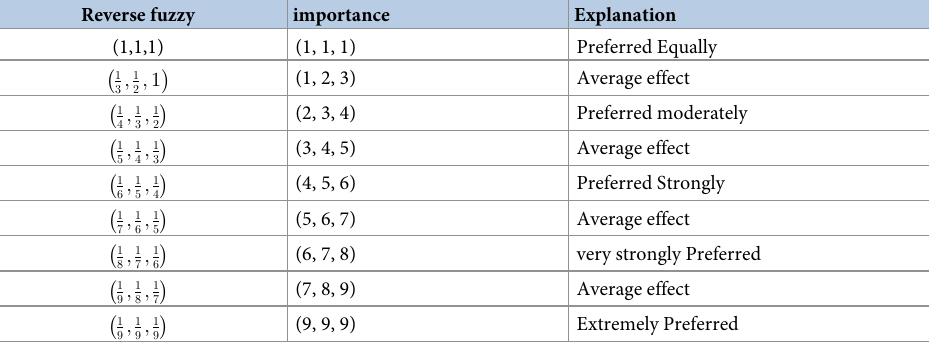
Table 3. Fuzzy continuum equal to Saaty’s 9-degree scale.